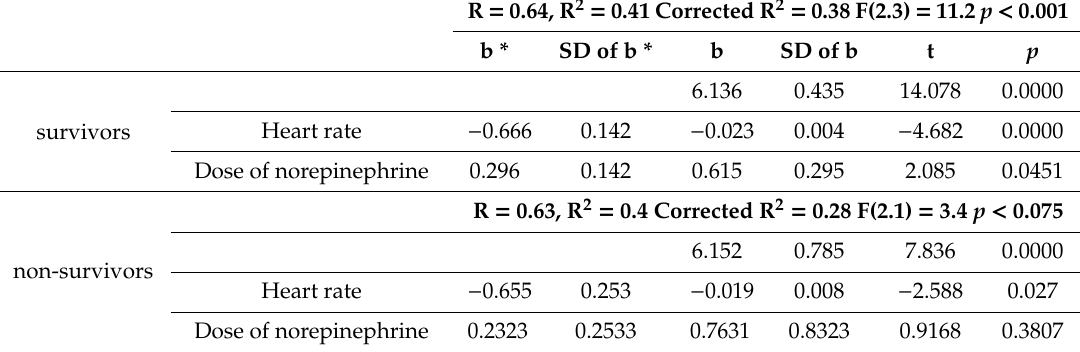
Table4. Multipleregressionanalysisshowingthedependenceoftheindexofcardiac-electrophysiological balance (iCEB) on parameters selected based on Pearson’s correlations in survivors and